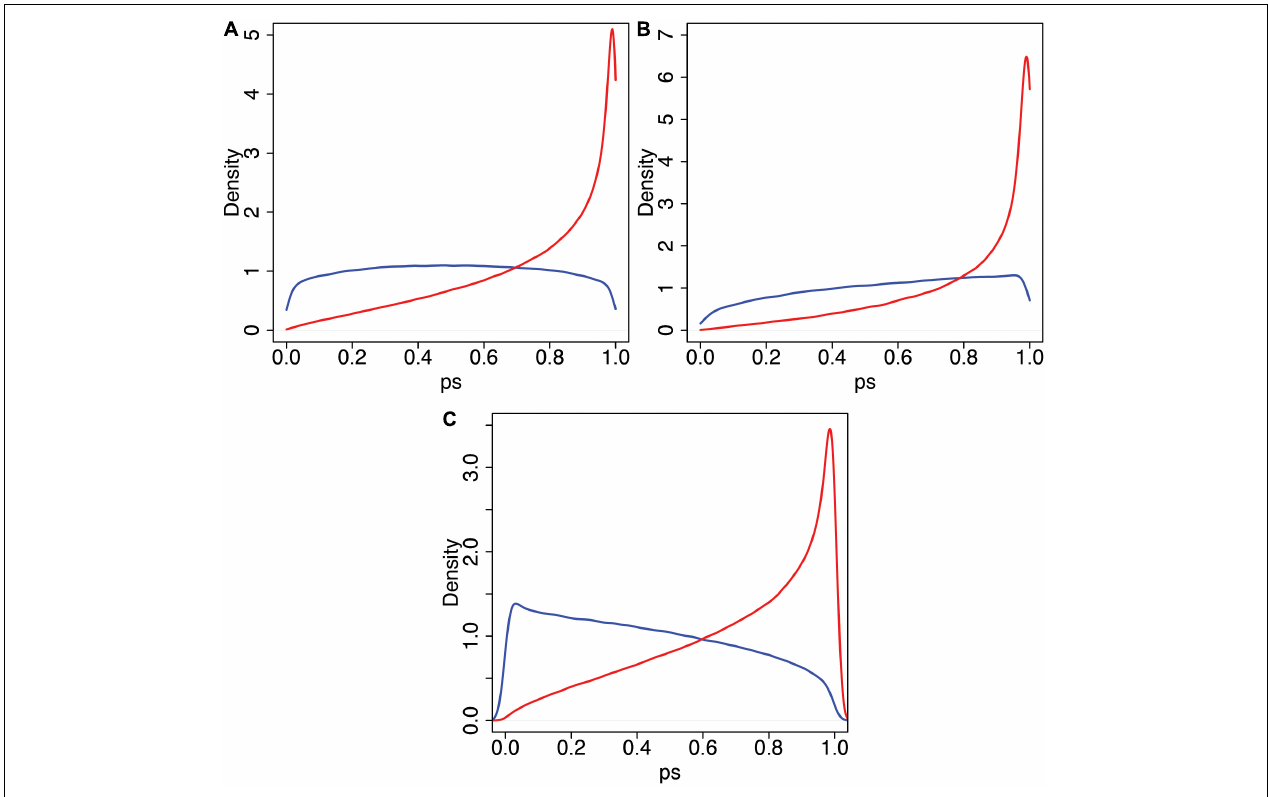
FIGURE 8 | The predicted posterior distribution of ps . (A) For values of swash > 1 . 60 (the median). (B) For values of swash > 2 . 64 (the 90th percentile). (C) For expect > 1. In each case, the blue curve is for asynchronous, and the red curve is for synchronous. Note that the characteristic difference between conditions is evident in each case, with the synchronous condition always being associated with higher probability (density) of high RHI scores across the two levels of trait hypnotisability ( swash ) displayed. TABLE 5 | P ( ps > 0 . 827 | swash > s , cond = c ) for s = 1 . 6 , 2 . 64 and c = 0 , 1.